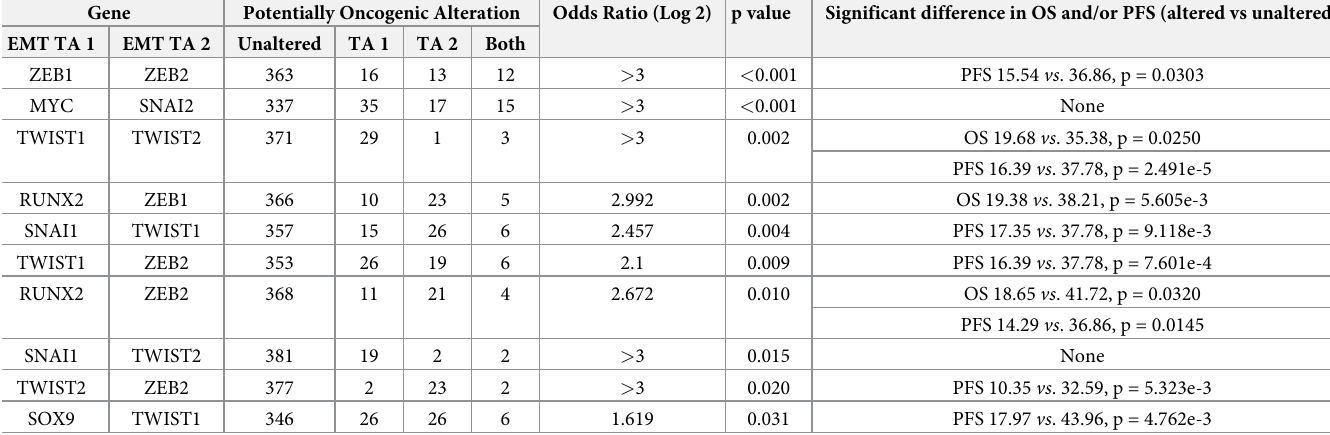
Table 4. Significant co-occurrence of potentially oncogenic alteration (overexpression per RNASeq V2 > 2-fold, and/or gene amplification) among EMT TAs in TCGA dataset analyzed by Robertson et al. (n = 408) [22] and associated differences in median OS and PFS.